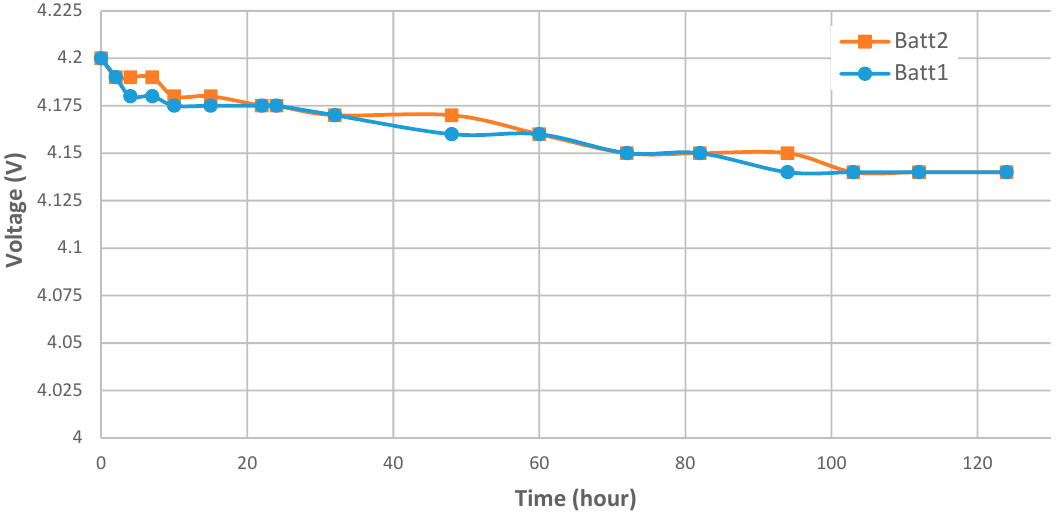
Figure 9. Time-domain trends of the open-circuit voltages of the two LiPo batteries.